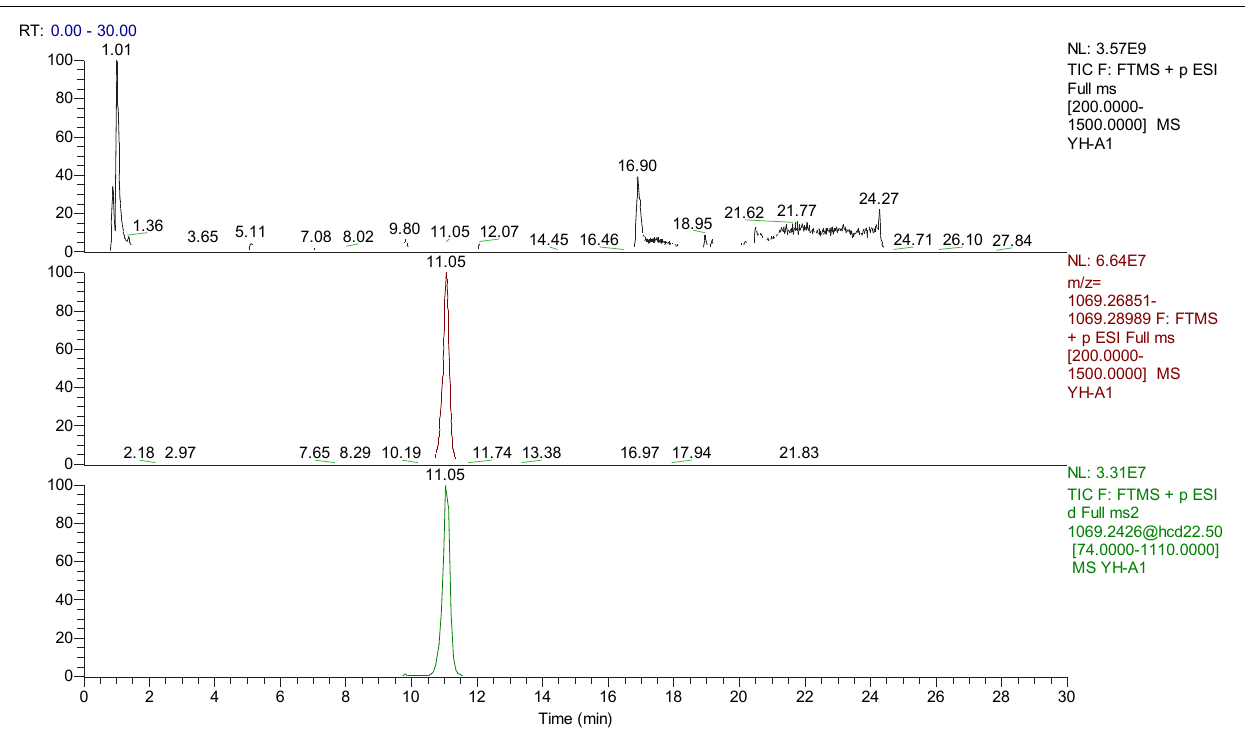
water bath and cooled to the room temperature. Now the solution was centrifuged at 2,000 rpm for 30 min and the supernatant was transferred to a petri dish and dried at 70 ◦ C in a vacuum oven until amylose was obtained by constant